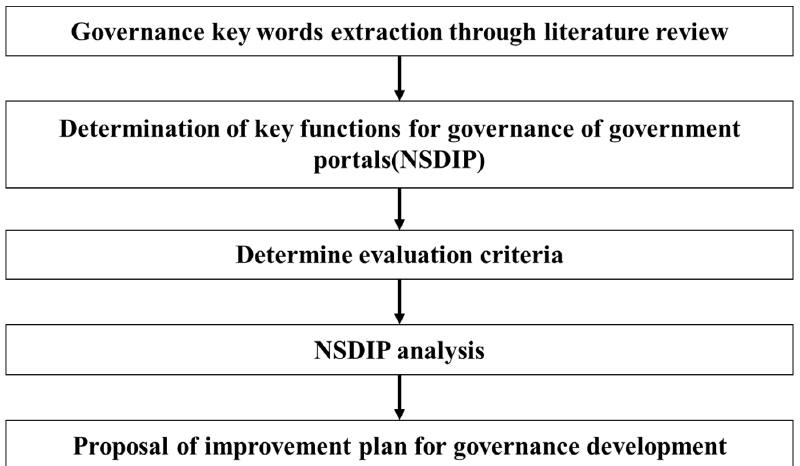
Figure 1. Research flow chart.